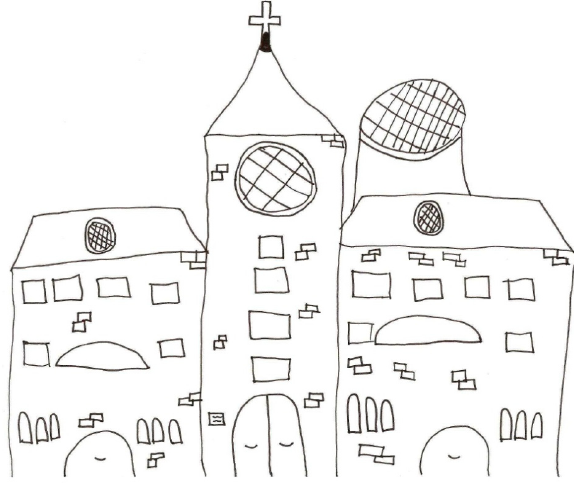
Figure 4. Expectation drawing showing proportionality and stonework.